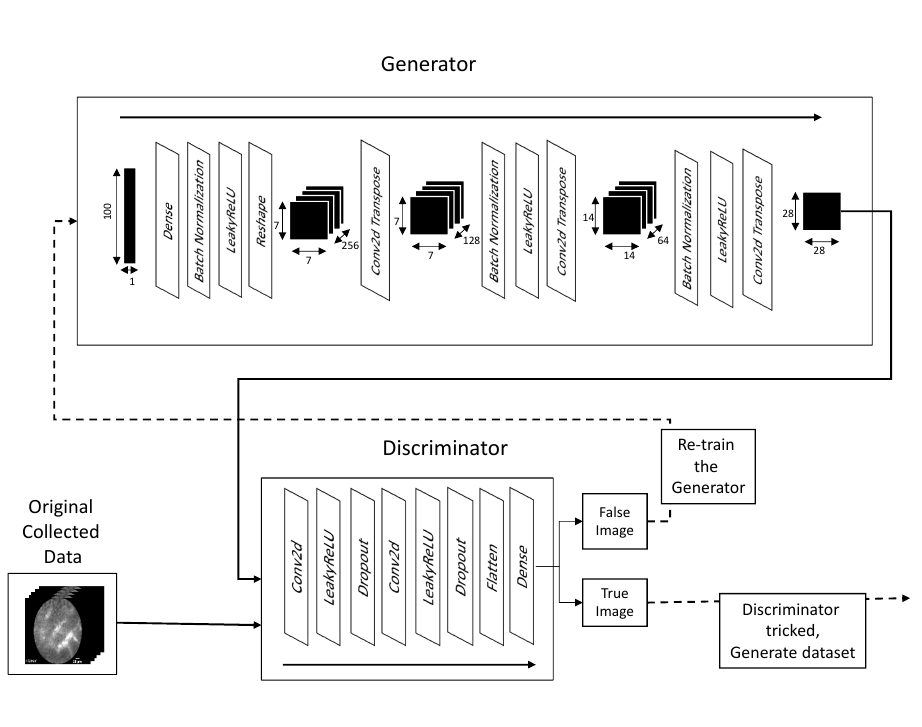
Figure 4. Illustration of generation process of generation and discrimination of